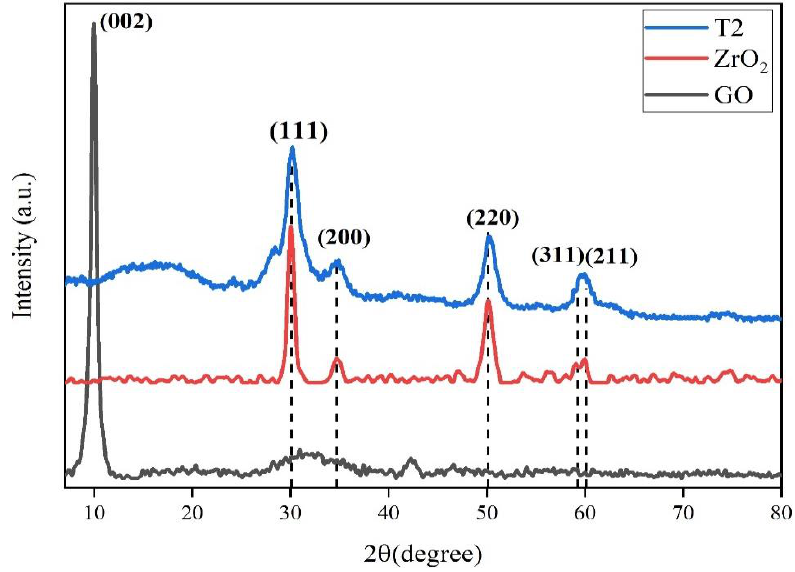
Figure 3. XRD pattern of RGO, ZrO 2 , and ZrO 2 /RGO composite T2.